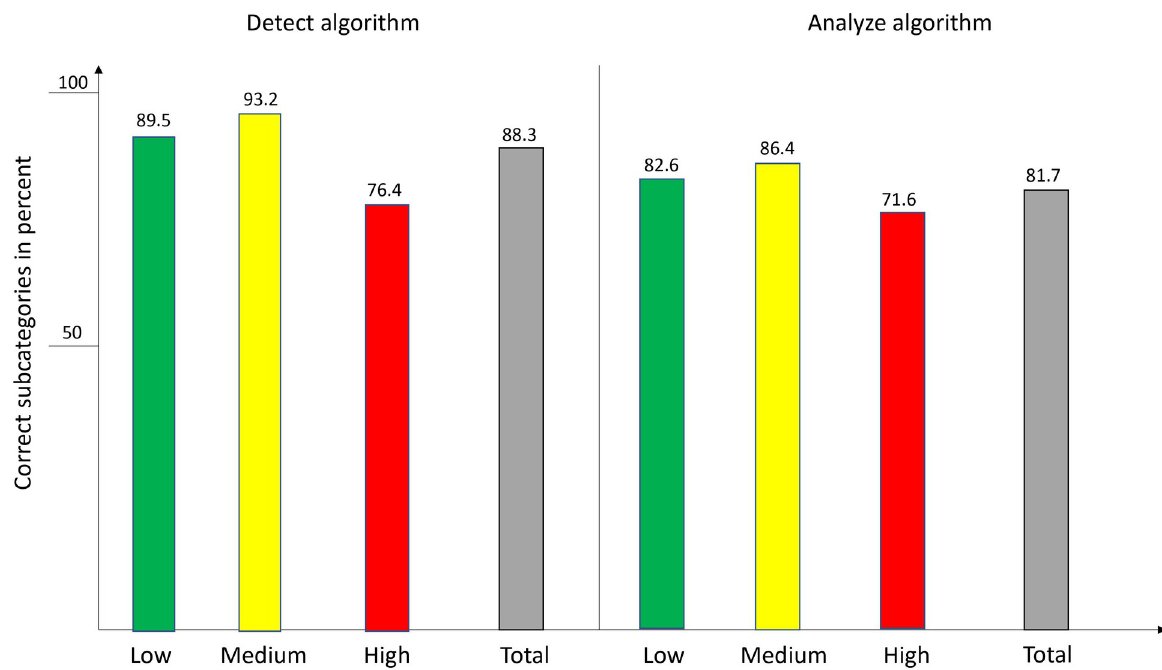
Fig 2. Diagnostic accuracy of both algorithms in the three risk levels as well as the overall diagnostic accuracy. The columns indicate the percentages of correct diagnoses in the respective risk level.